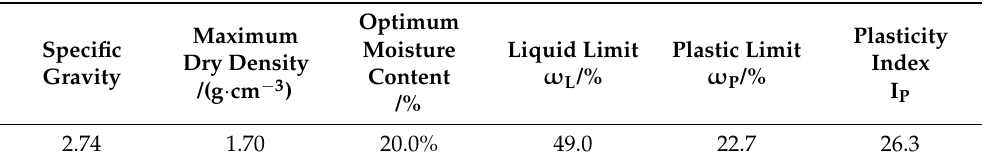
Table 1. Basic physical parameters of red clay.